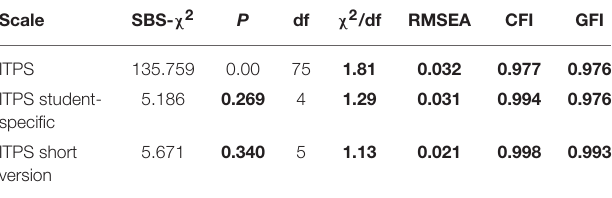
TABLE 2 | Fit indices of the CFA for the three